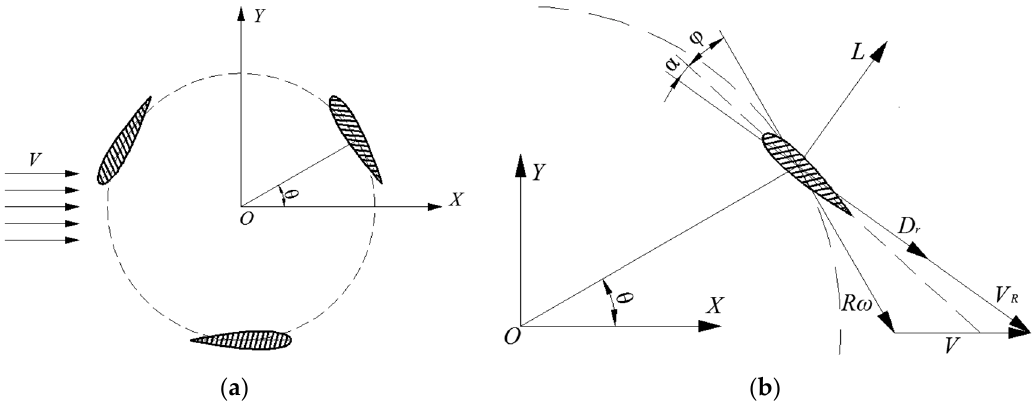
Figure 3. Position of the blades, ( a ) definition of the coordinate system; ( b ) forces on the blade. During the rotation, the blades generated the lift force L and drag force